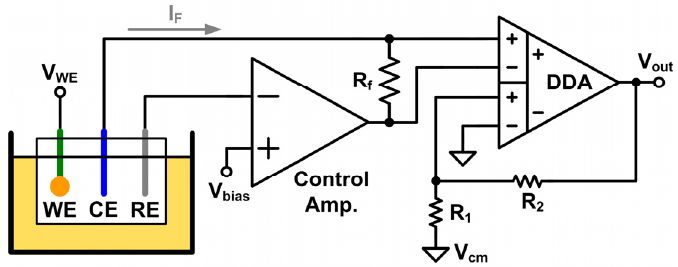
Figure 4. Set-up of the proposed potentiostat circuit for three-electrode amperometric